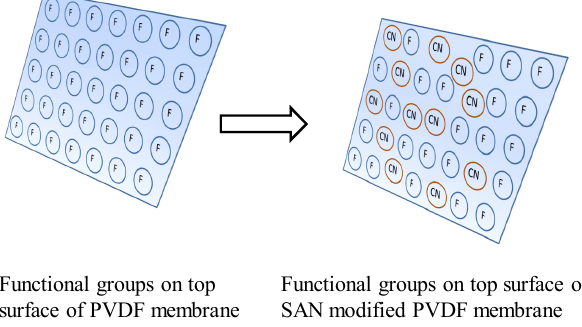
Figure 1. Scheme for modification of PVDF.